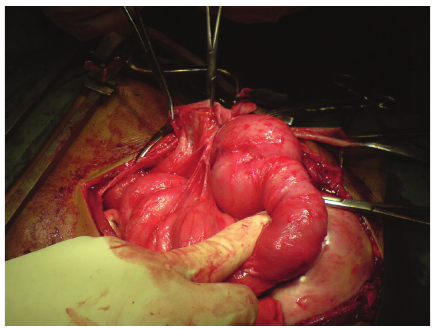
Figure 2: Densely adherent gut